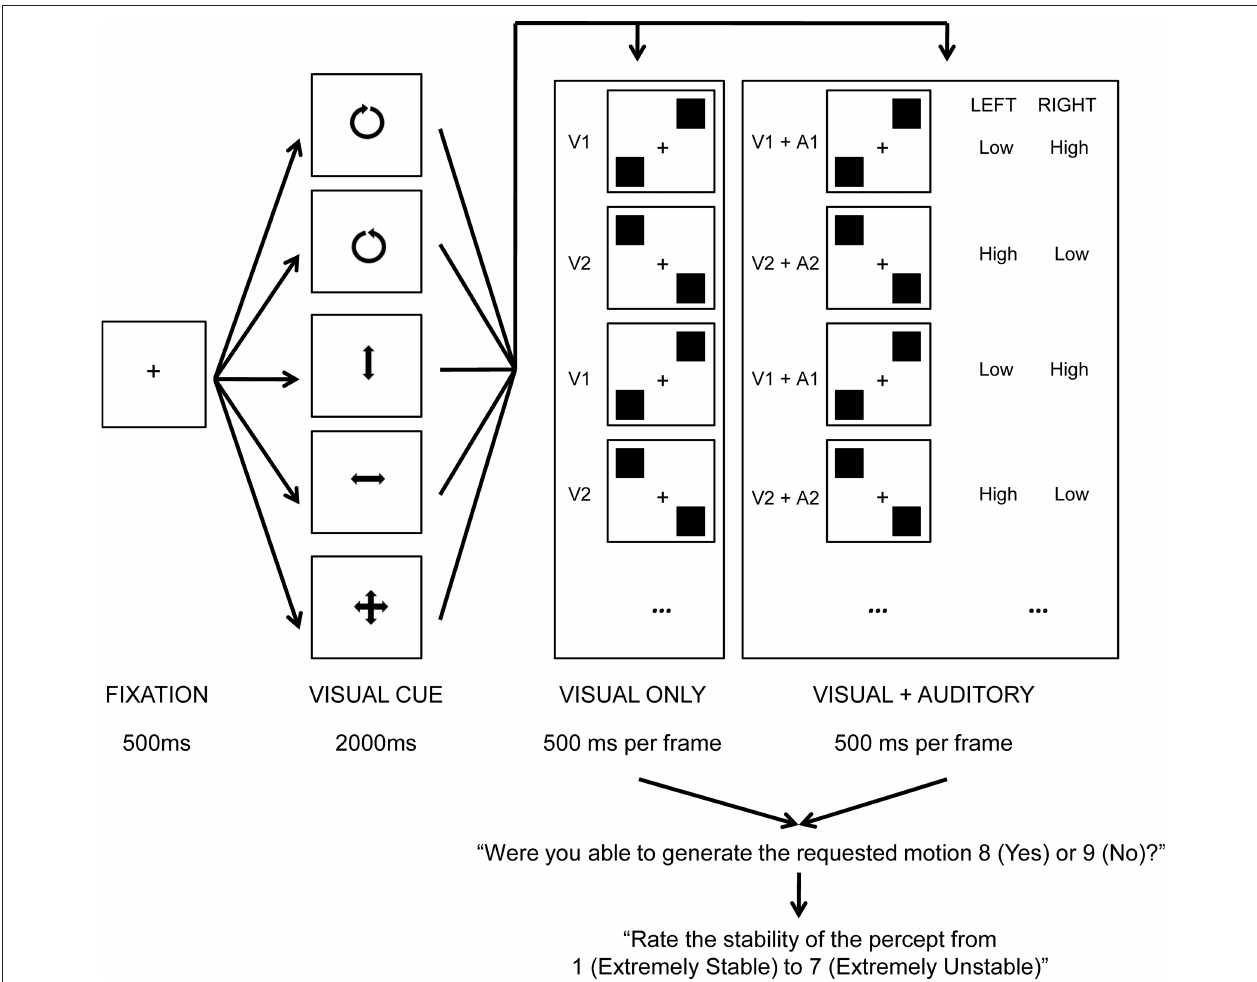
Figure 1 | Trial schematic of the experiment. A fixation cross was presented center screen for 500 ms after which a visual cue was presented for 2000 ms, indicating the desired motion for that trial (counter-clockwise, clockwise, vertical, horizontal, free-view). This was then replaced by eight iterations of either the V1,